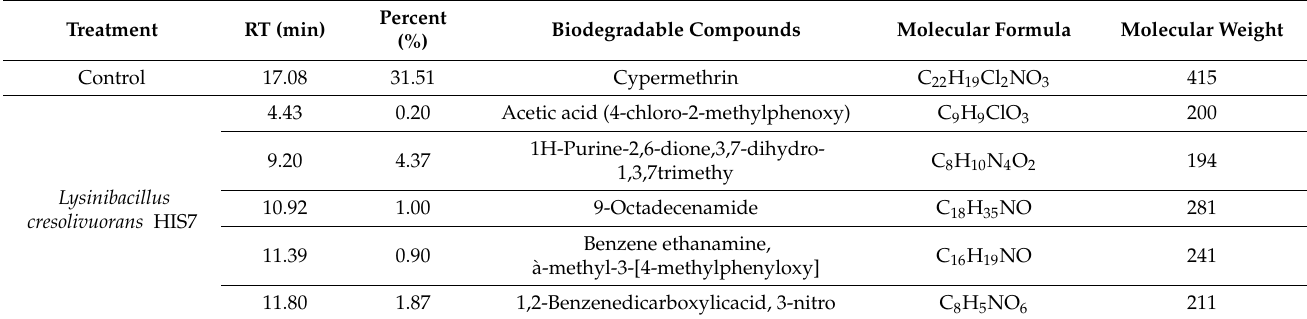
Table 2. Effect of cypermethrin and its biodegradable end products on seed germination of Zea mays plant. Treatment Root Length (cm) Positive control (distilled H 2 O) Negative control (cypermethrin before bacterial